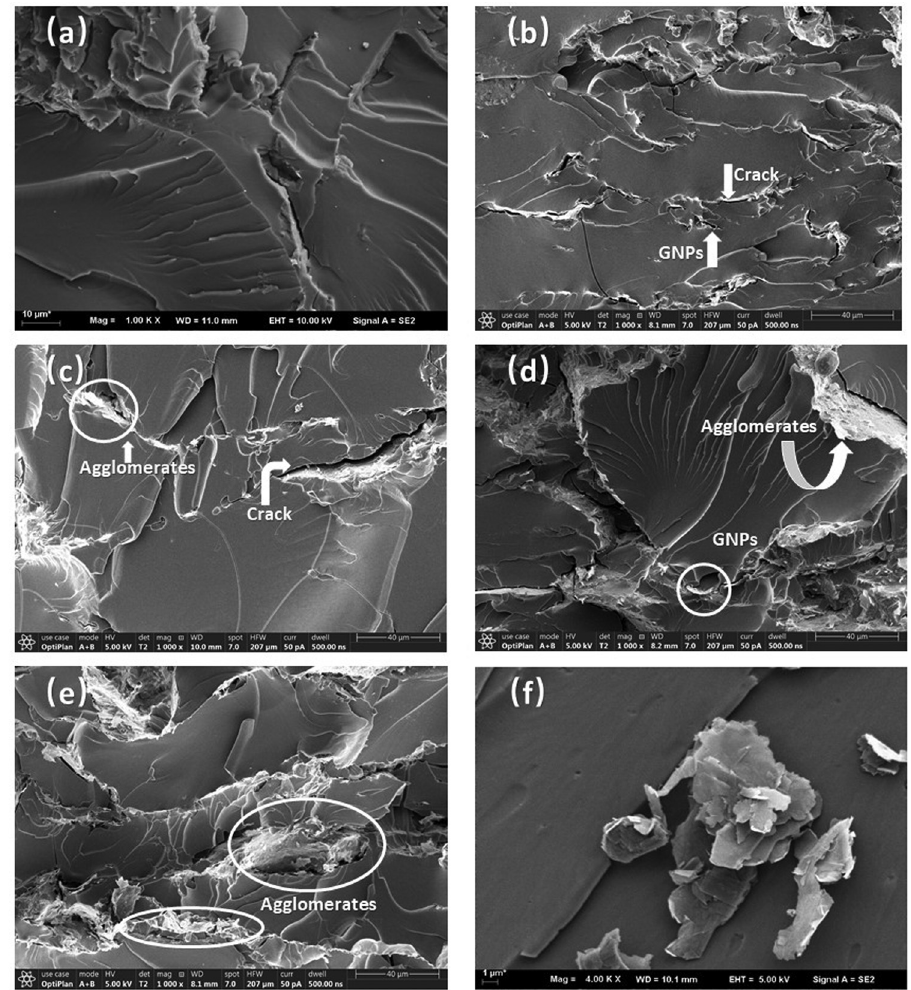
Figure 5: SEM images of tensile fracture surfaces of ( a ) polyimine and GNPs - P composites with di ff erent contents of GNPs: ( b ) 0.5 wt%, ( c ) 1 wt%, ( d ) 1.5 wt%, ( e ) 2 wt%, and ( f )